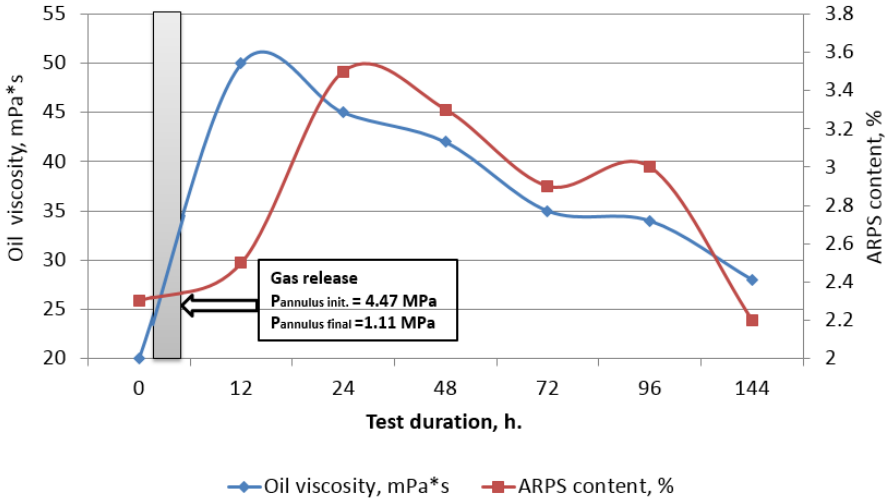
Figure 6. Variation of viscosity and ARPS content in oil after extraction of annular gas at the well No. 5597d.